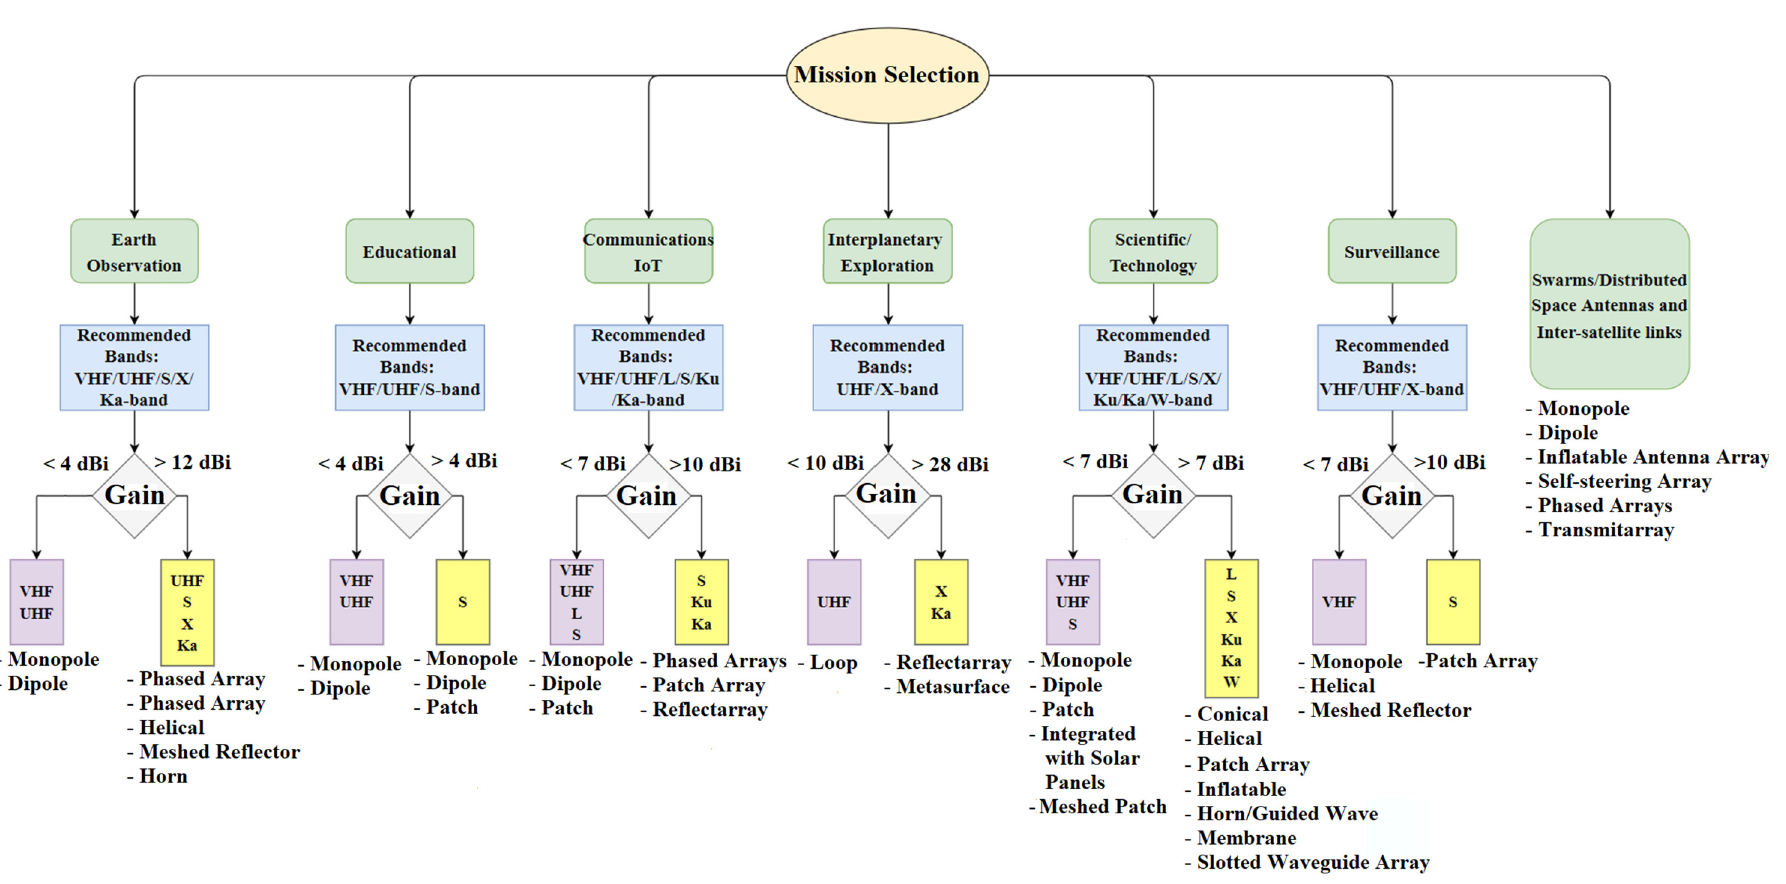
Figure 10. Antenna selection guide for different CubeSat missions.